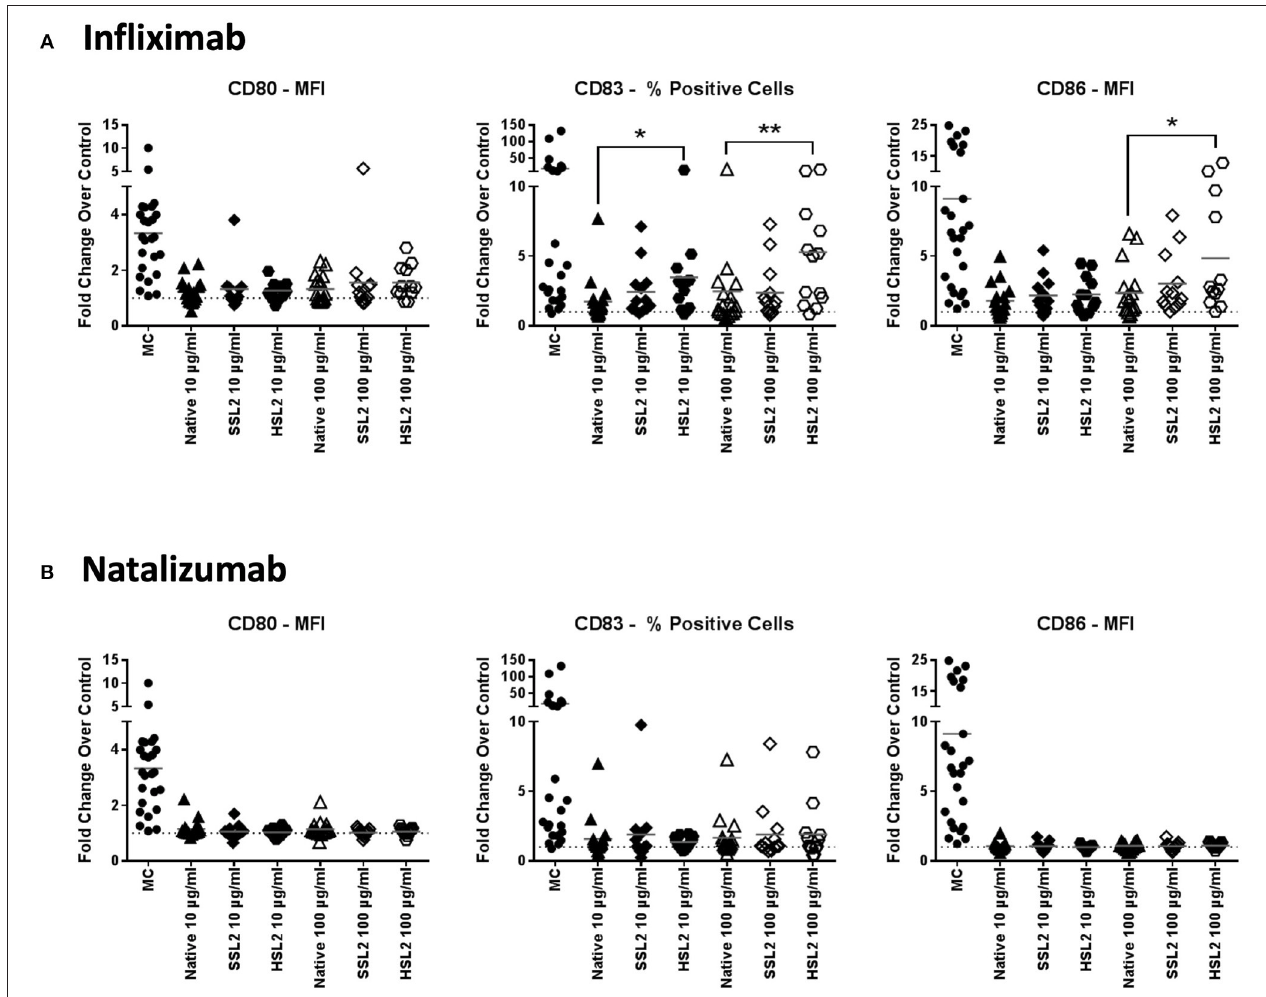
FIGURE 2 | Phenotypic assessment of maturation marker expression on moDC following treatment with native or aggregated infliximab (A) and natalizumab (B) . Immature moDC were treated for 48h with the positive control (MC; maturation cocktail as described in the Methods section), native or stressed (SSL2 or HSL2) therapeutic antibodies at 10 or 100 µ g/mL. Cells were collected, washed, and analyzed by flow cytometry for CD80, CD83, and CD86 expression was measured on CD11c + moDC. Results are expressed as the fold change of marker expression (either as the MFI or as the % of positive cells based on the sensitivity of responses to the positive control for each marker) compared to PBS treated cells (represented by the horizontal dotted line at 1.0). Results from 12–23 independent experiments are shown, individual points representing individual donor responses. The group’s mean is represented by the horizontal gray line. * p < 0.05; ** p < 0.01 . .